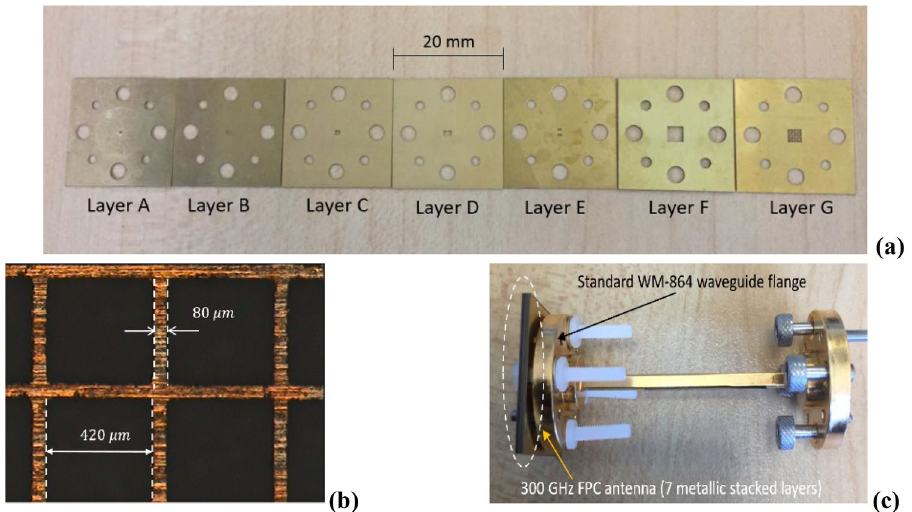
Figure 6. Photographs ( a ) 7 brass metal layers required to assemble one antenna, ( b ) microscope image of the aperture-type FSS layer and, ( c ) the manufactured antenna mounted on a standard WM-864 waveguide flange. The antenna is aligned using two standard alignment pins and fixated with four plastic screws. The standard flange size is 20 mm × 20